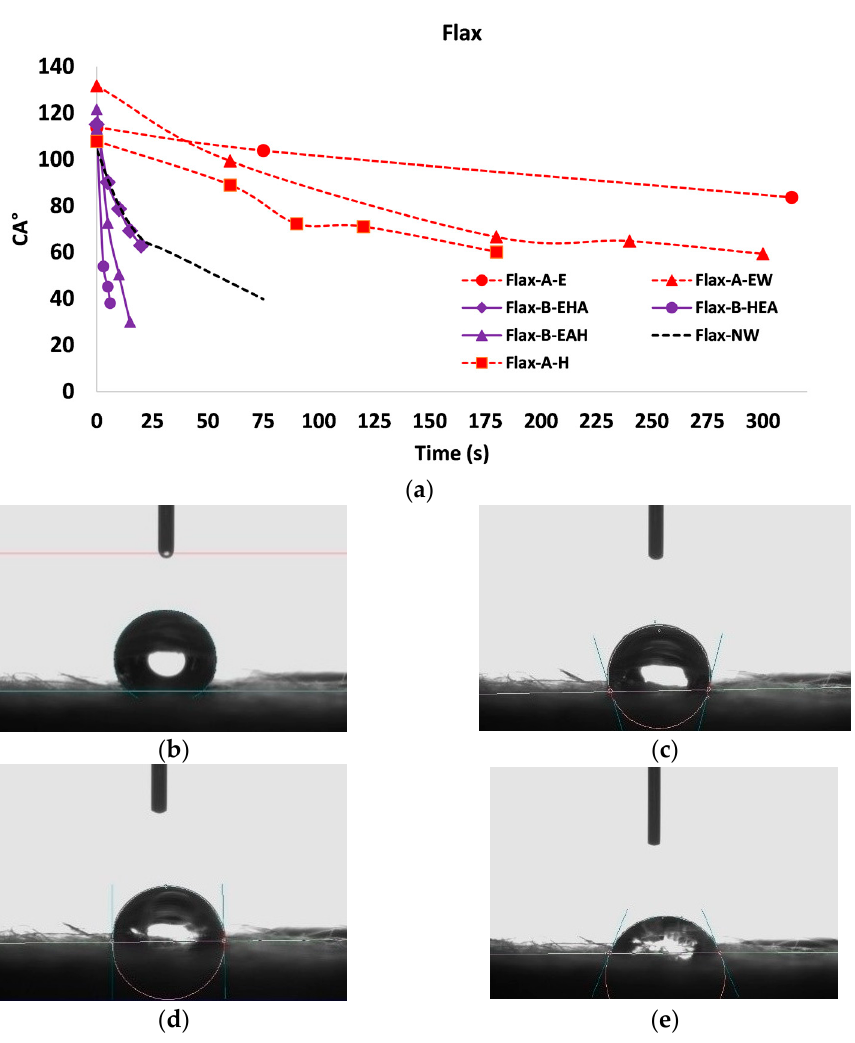
Figure 8. ( a ) Results obtained for the SCA of flax fibers; images of the SCA of Flax-A-H at ( b ) 0 s; ( c ) 60 s; ( d ) 120 s and ( e ) 150 s.